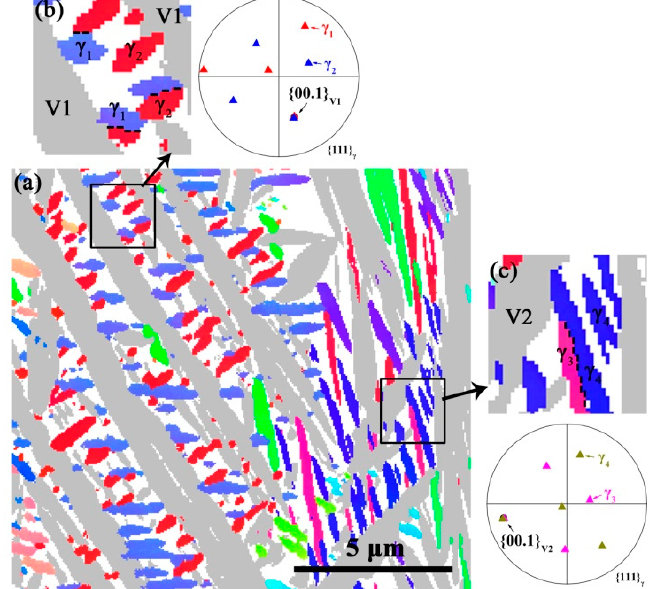
Figure 8. ( a ) The local inverse pole figure map shows the γ orientations. The α 2 ′ phase is in gray. ( b ) and ( c ) show that the two γ variants derived from one α 2 ′ lath are twin-related. The dash lines denote the twin boundaries. The {00.1} α 2 ′ poles are superimposed on the corresponding {111} γ pole figures.